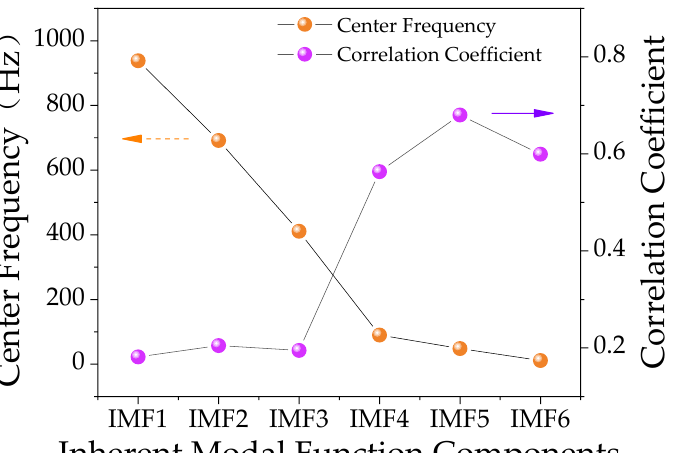
Figure 5. Results of the first layer VMD decomposition of vibration signal under normal operation.